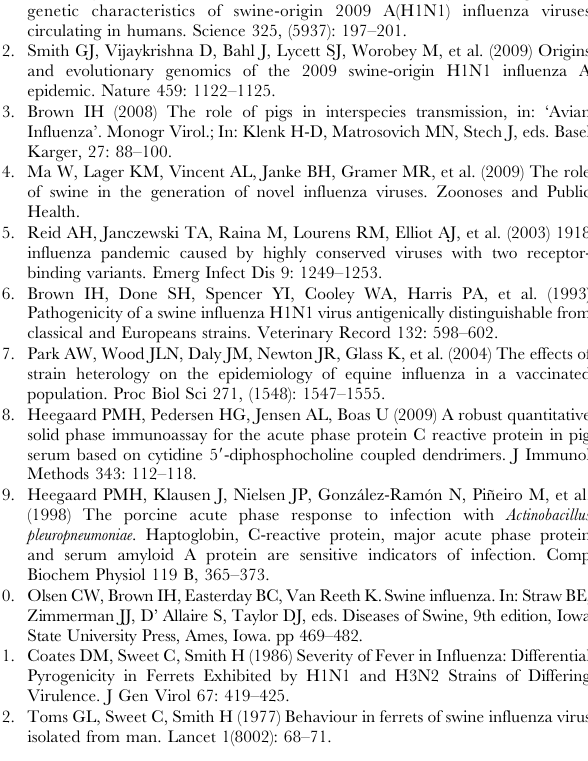
Table S1 Clinical scoring system for influenza A challenge in pigs. Figure S1 Study plan including timeline (date and day post- infection), animal numbers, post-mortem examinations (PME), transmission cycles (TC) and animal movements. An unplanned PME was carried out on pig 3261 dpi 17 on welfare grounds. Figure S2 Mean daily rectal temperature (oC) plus standard errors for infected (INF), transmission cycle (TC) and control (C) pigs.